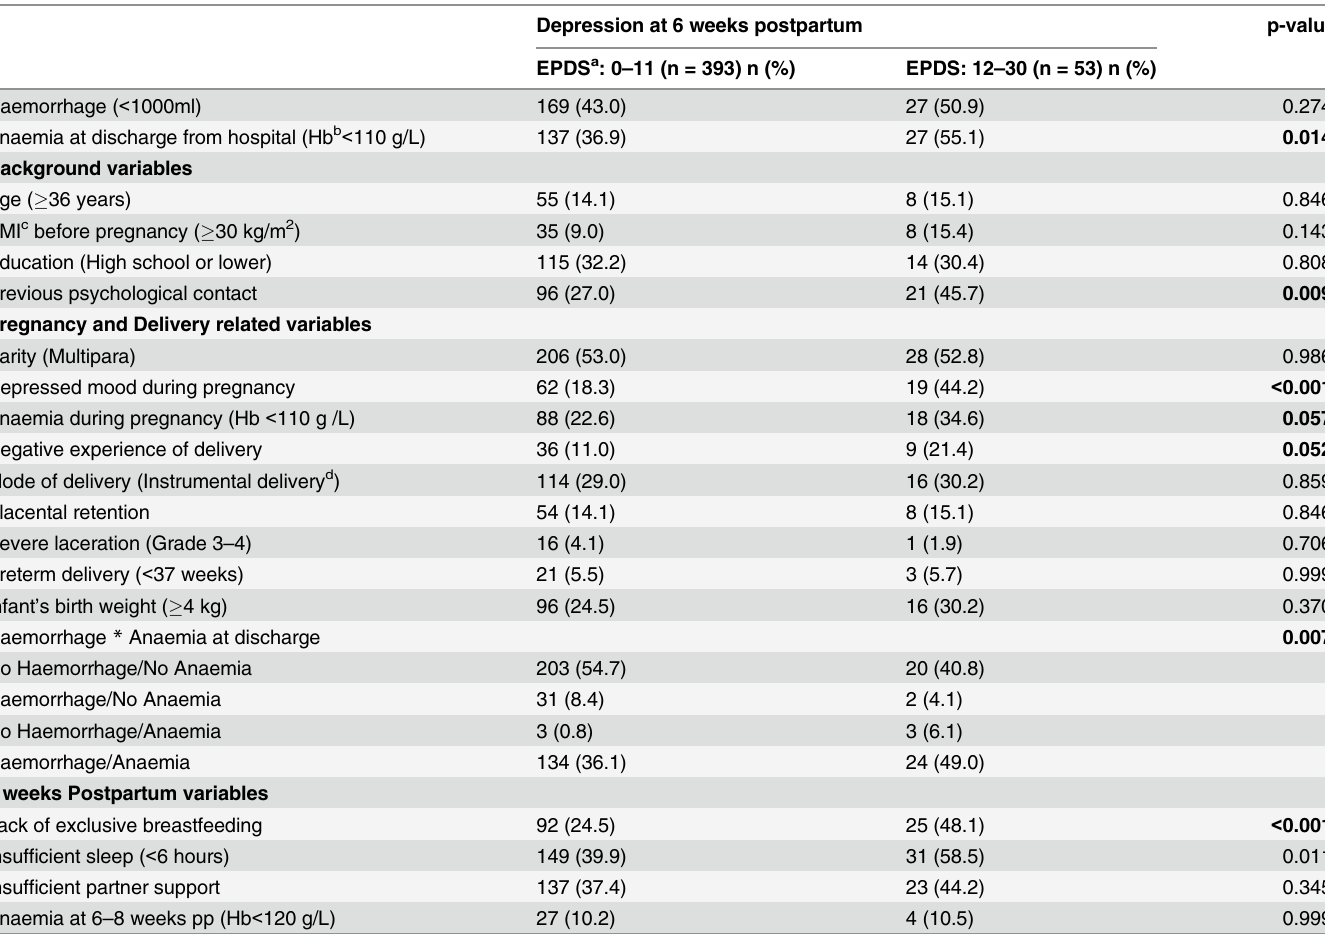
Table 2. Distribution of study participants by demographic, perinatal and clinical characteristics and association with self-reported depression status at 6 weeks postpartum. Depression at 6 weeks